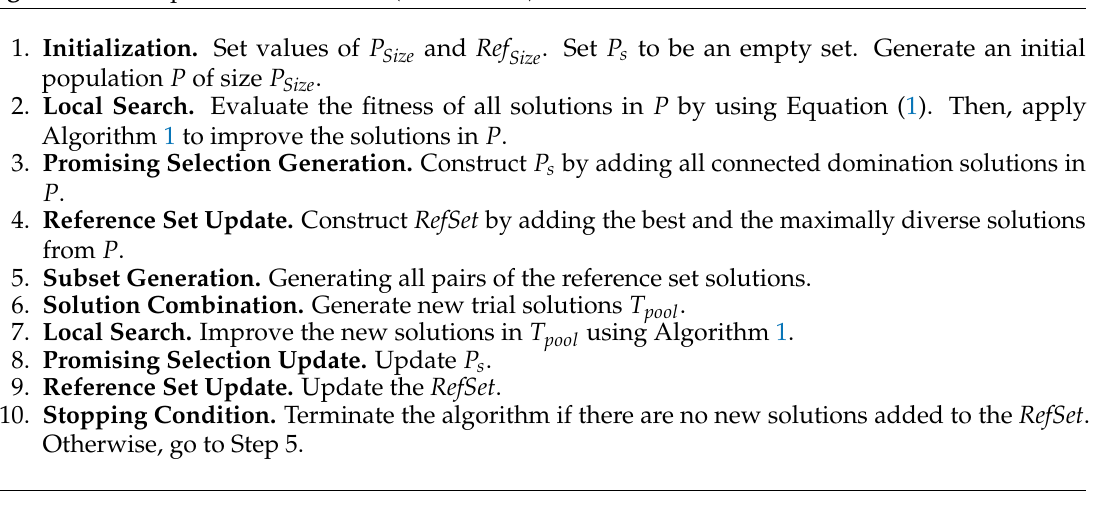
Algorithm 2 Adaptive Scatter Search